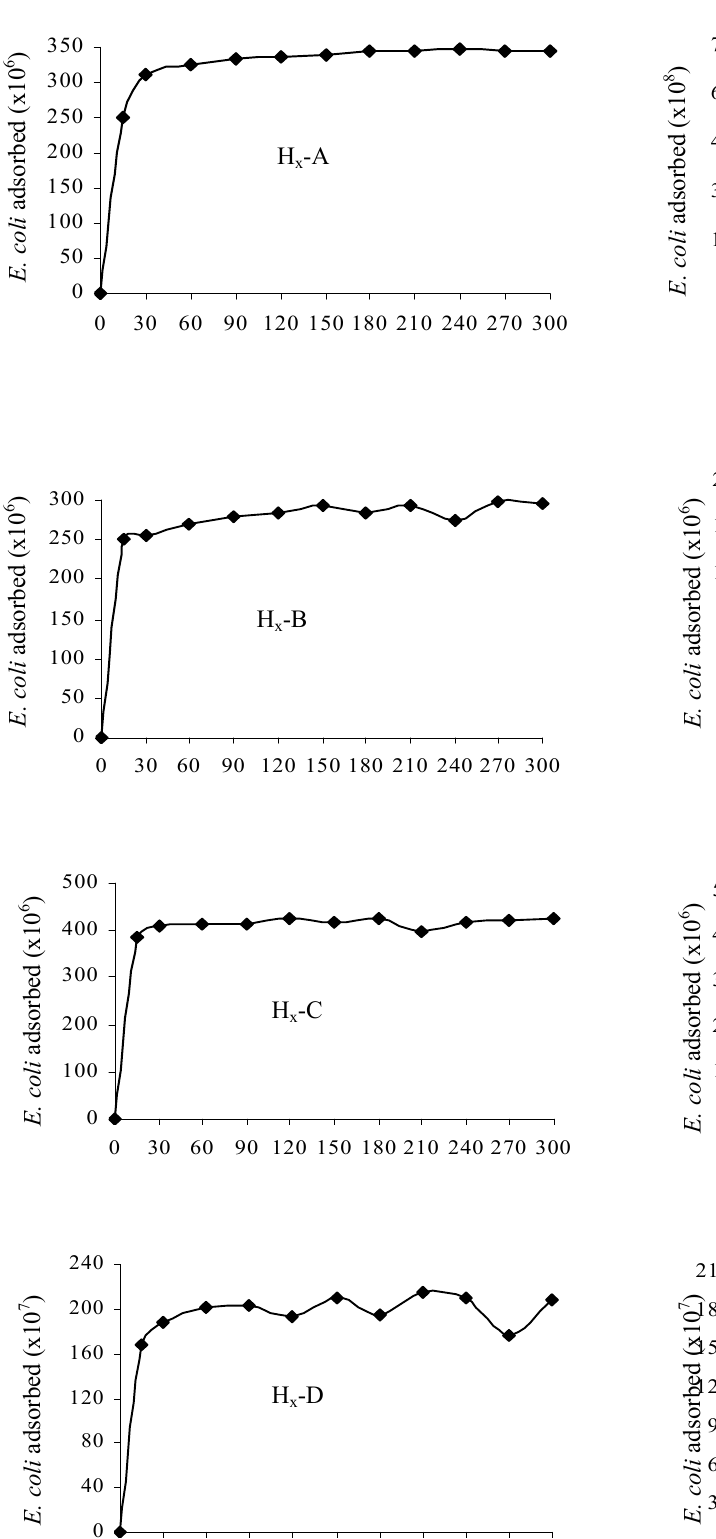
Figure 1: Temporal variations of adsorbed E. coli .mg-1 of soil particles, tests carried out with 500 mg (A), 200 mg (B), 100 mg (C) and 50 mg (D) of soil horizon H